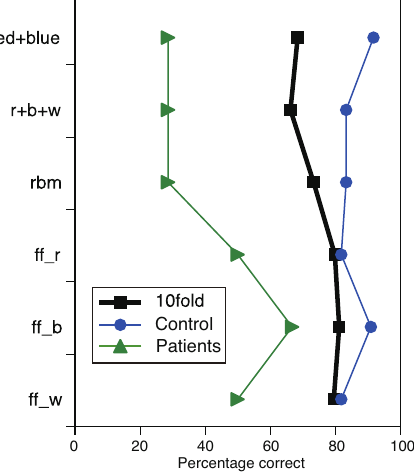
Table 4. Age affected Features (list of significant variables)